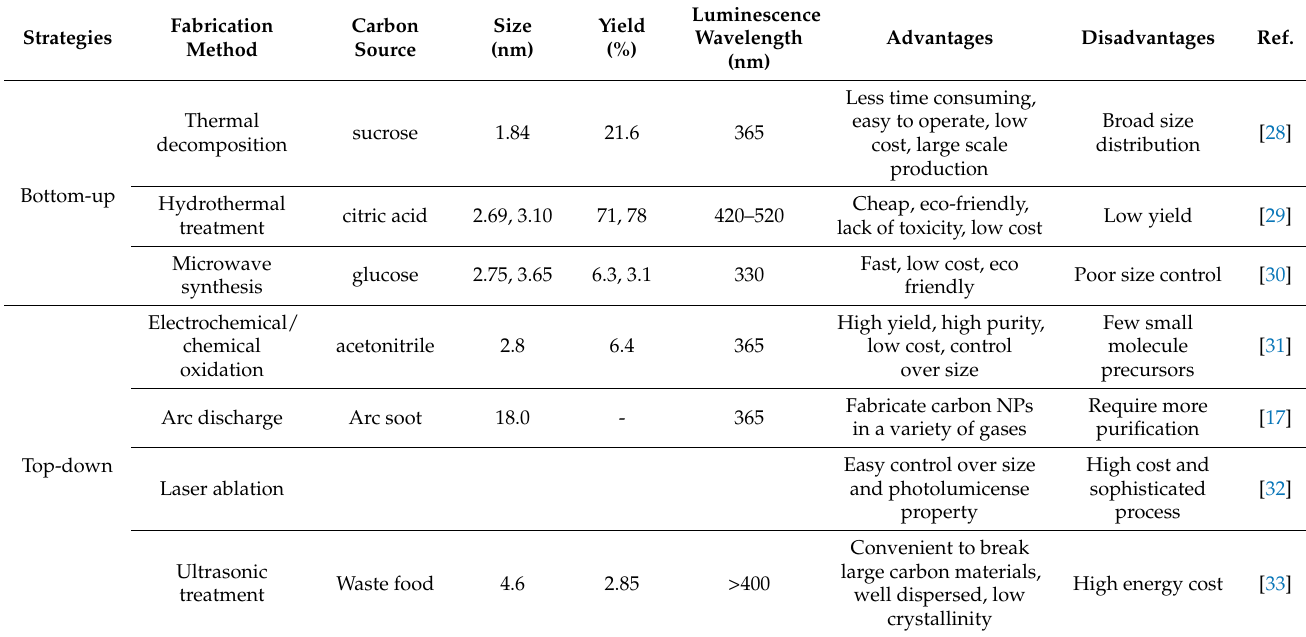
Table 1. Advantages and disadvantages of different methods of C-dots